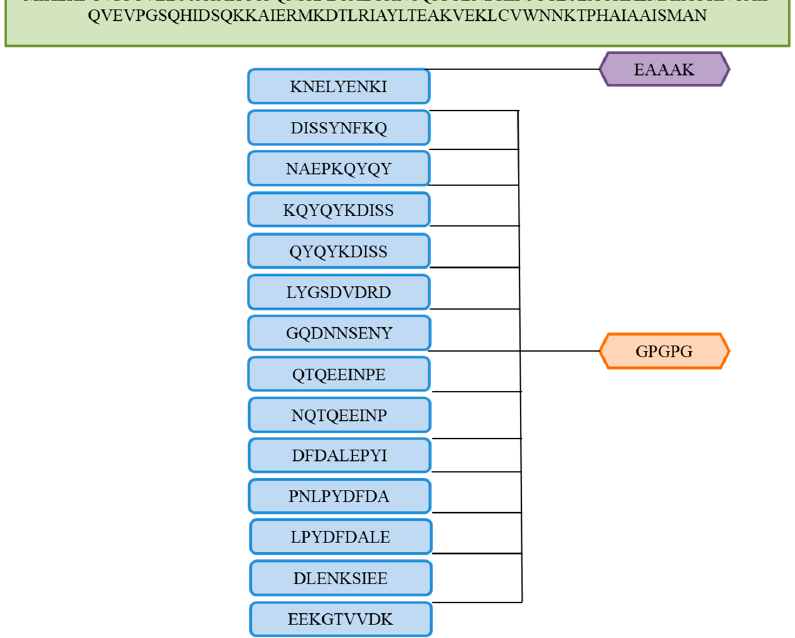
Figure 6. The vaccine construct is described in a schematic diagram. In the orange color, we can see the linker (GPGPG) that is used to link selected epitopes. Green represents cholera toxin B ‐ subunit (adjuvant) and purple represents EAAAK (linker).